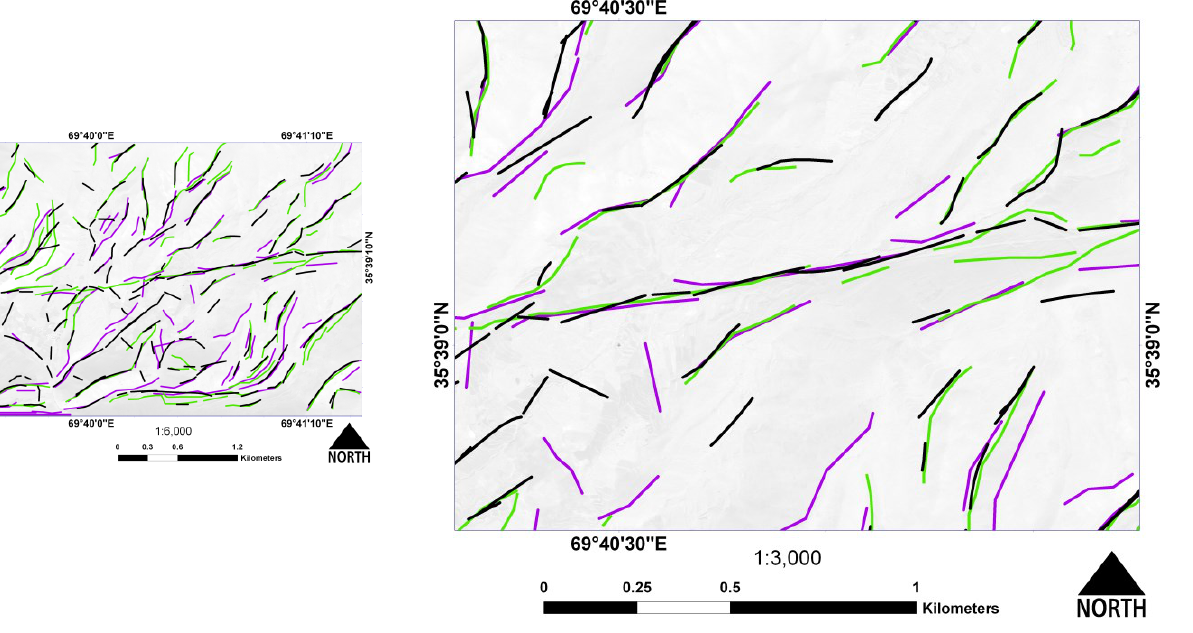
Figure 15. Superimposition of discontinuities extrapolated from Canny data sources (black lines) and the reference discontinuities, which are manually extracted (green lines), and automatically lineaments extracted by PCI Geomatica software (violet lines).